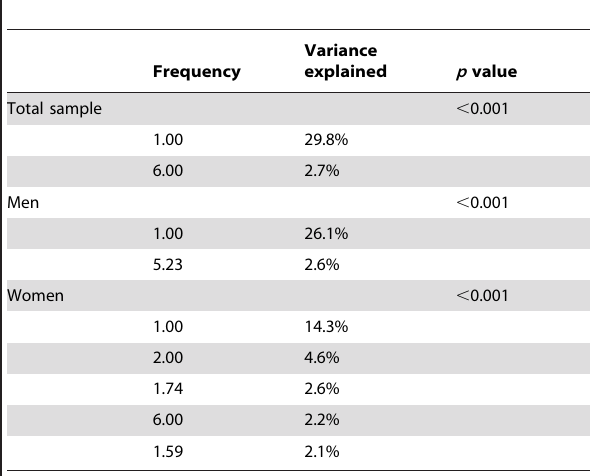
Table 1. Suicide seasonality for the total sample, men and women (all methods).